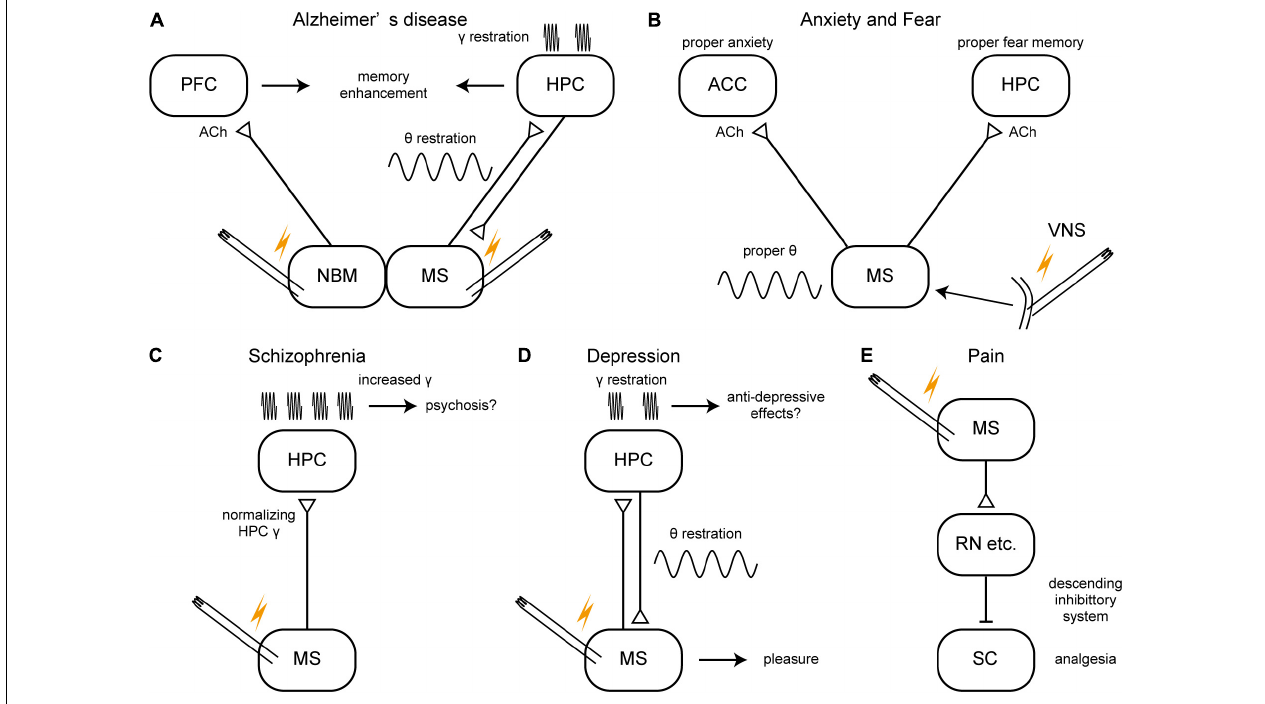
FIGURE 4 | A schema of hypothetical therapeutic strategies of brain disorders via the medial septum. (A–E) Potential therapeutic strategies of Alzheimer’s disease, anxiety/fear, schizophrenia, depression, and pain. ACC, anterior cingulate cortex; ACh, acetylcholine; HPC, hippocampus; MS, medial septum; NBM, nucleus basalis of Meynert; PFC, prefrontal cortex; RN, raphe nucleus, SC, spinal cord; VNS, vagus nerve